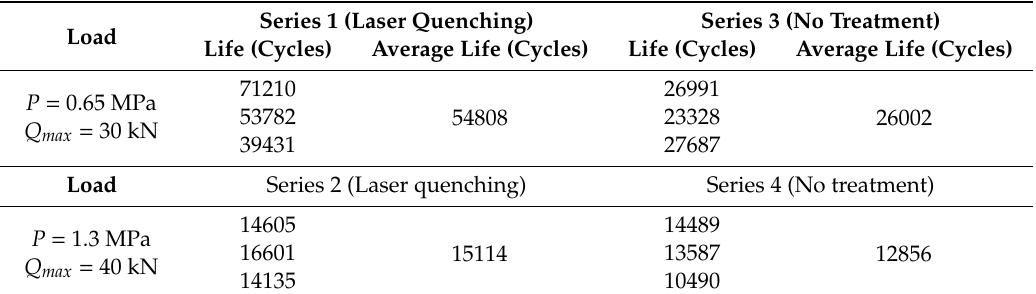
Table 4. Experimental fretting fatigue initiation life of TC11 with di ff erent surface treatments.